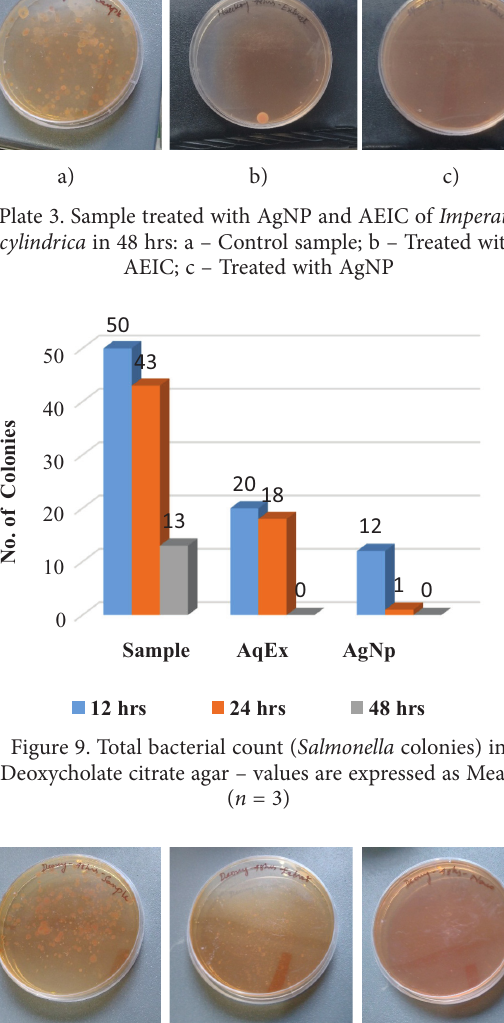
a) b) c) Plate 4. Sample treated with AgNP and AEIC of